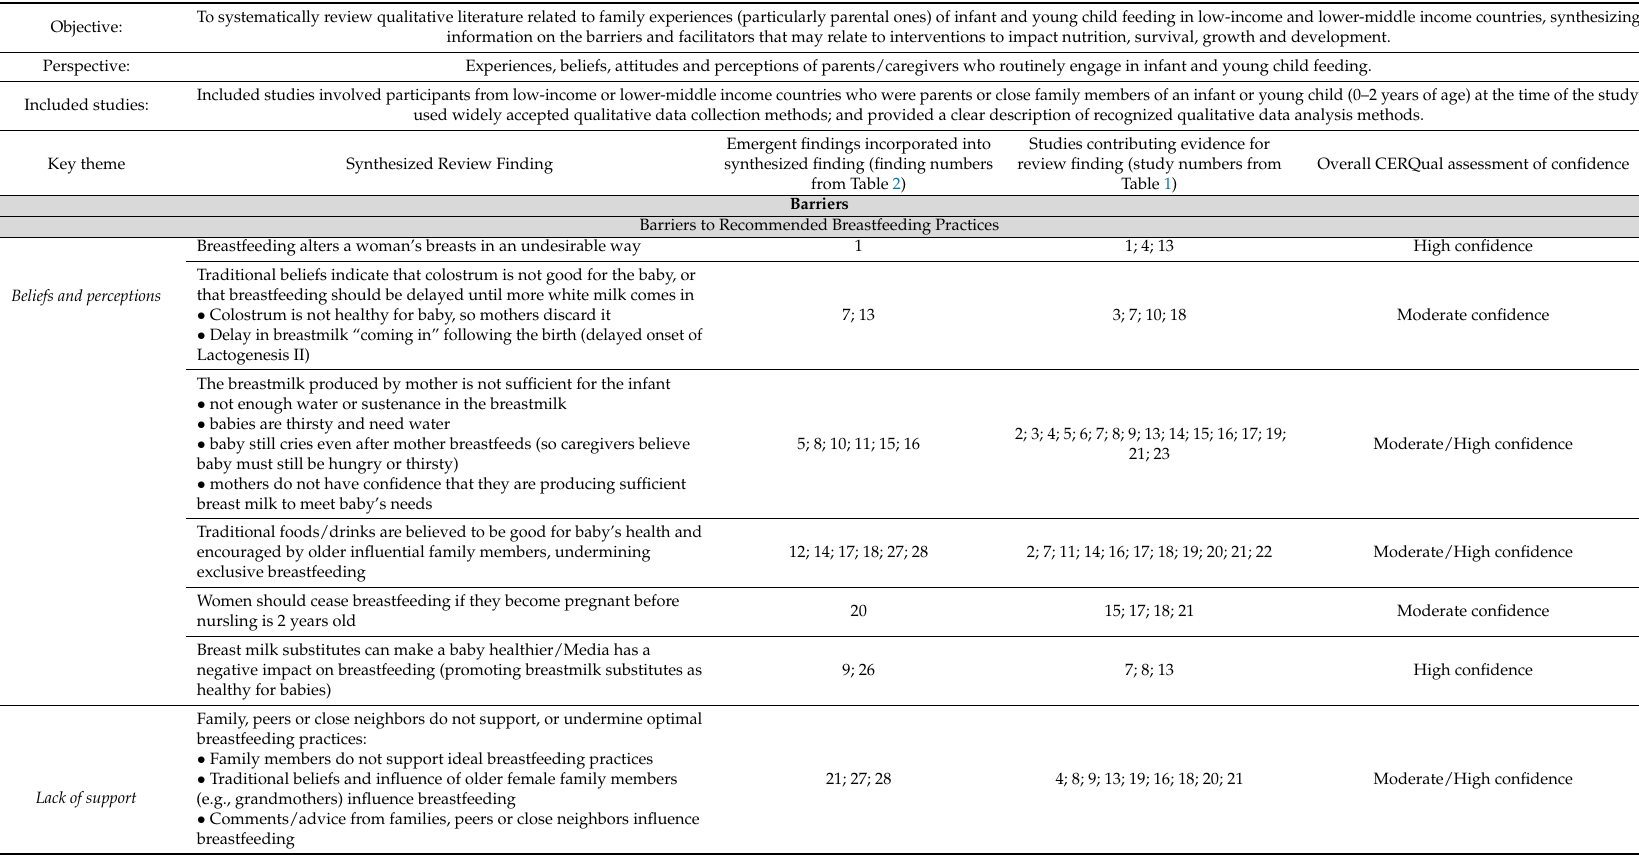
Table 3. CERQual summary of qualitative review